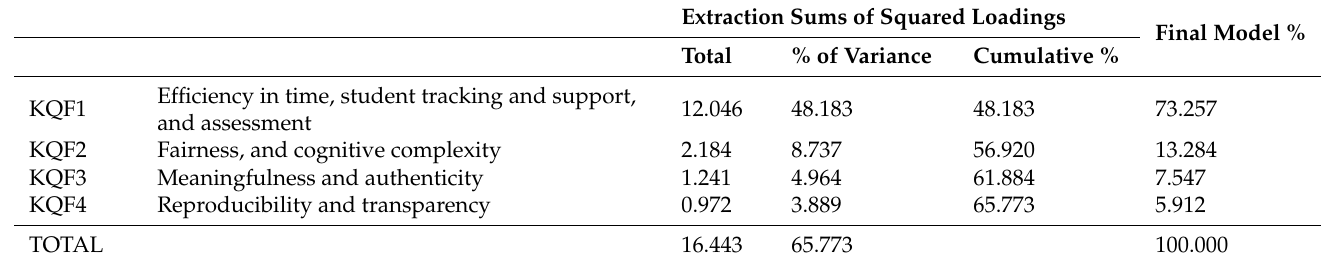
Table 6. KQF identified and related